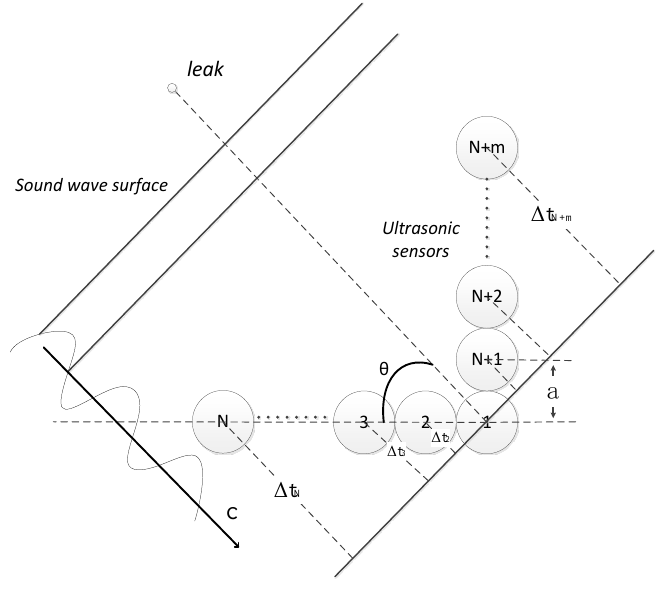
Figure 2. The model of the sensor